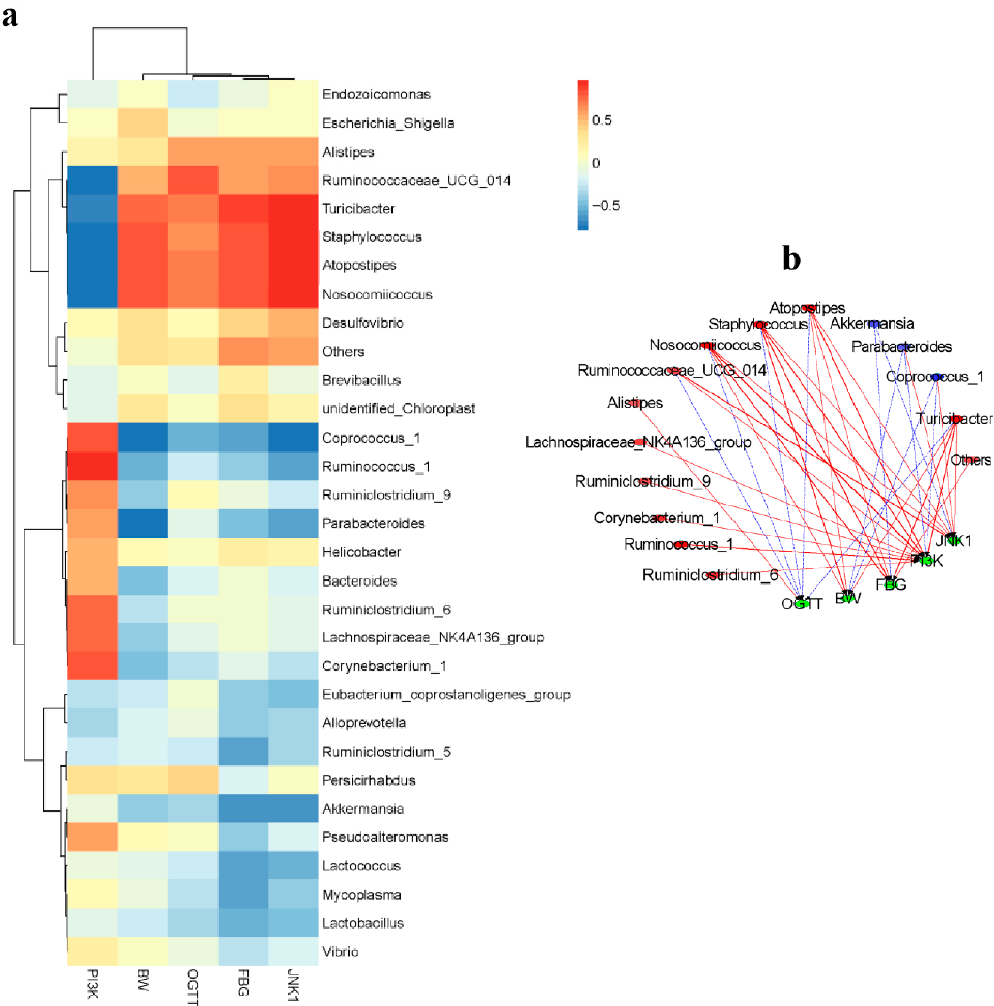
Figure 5. ( a ) Analysis of heat map of gut microbiota with biochemical indexes and mRNA expression levels. Red region represents positive correlation, blue region represents negative correlation, and the shades of color indicates the strength of relevance among them. ( b ) Analysis of network of gut microbiota, biochemical indexes, and gene expression levels. The solid red line and dotted blue line represented positive and negative correlation, respectively. In addition, the line width indicated the strength of correlation; the edges were drawn in the network using the Spearman correlation (| r | > 0.6).